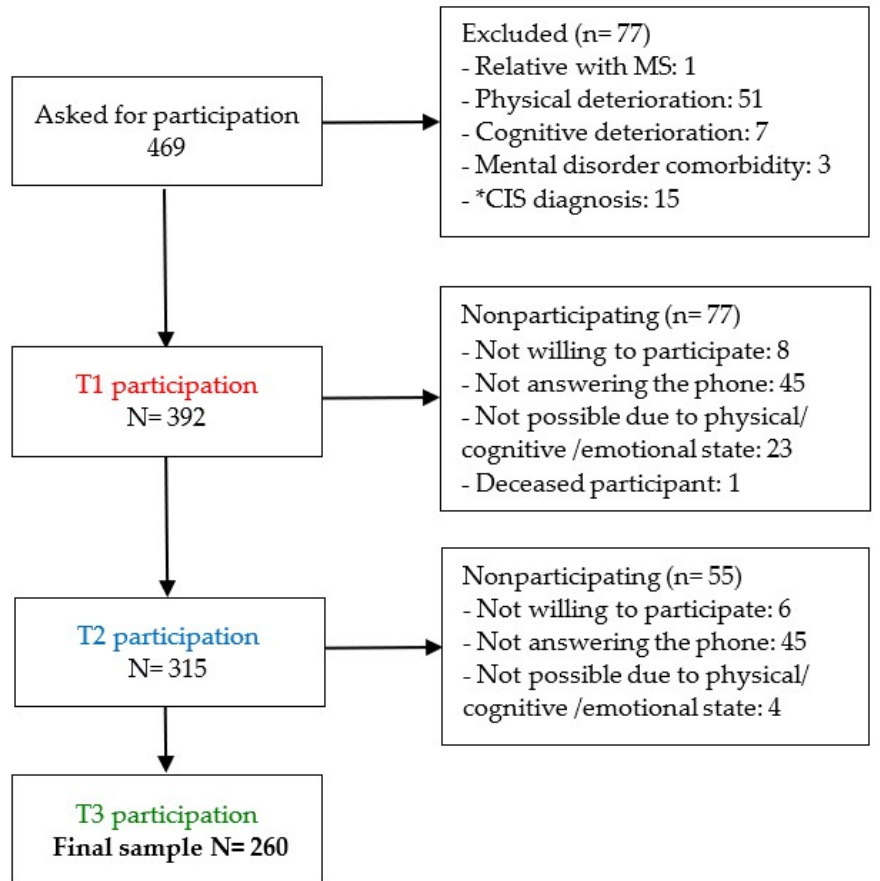
Figure 1. Study flow-chart. * Note. CIS = Clinically isolated syndrome. The sample selection process at the three different periods in different colors.